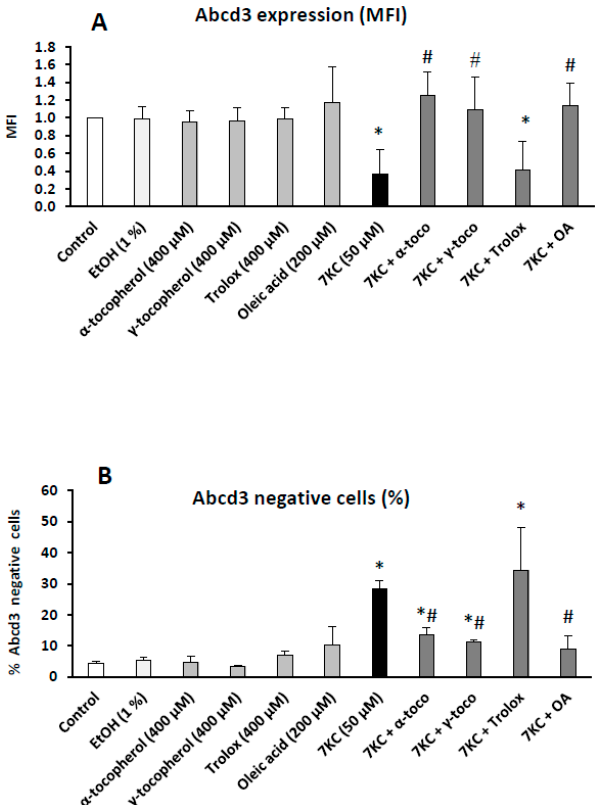
Figure 3. Protective effects of α -tocopherol, and γ -tocopherol, and oleic acid on 7-ketocholesterol-induced decreased expression of Abcd3, a marker of peroxisomal mass. Murine microglial BV-2 cells were cultured for 24 h in the presence of 7KC (50 µM) without and with α -, and γ -tocopherol (400 µM), Trolox (400 µM) and oleic acid (OA: 200 µM), and the expression of Abcd3 determined with the mean fluorescence intensity (MFI) was evaluated by flow cytometry ( A ); in addition, the percentage of Abcd3-negative cells was determined ( B ); No difference was observed between control and vehicle (EtOH 1%)-treated cells. The EtOH values correspond to the highest EtOH concentrations added to the culture medium: 1% with γ -tocopherol. Differences between vehicle and 7KC-treated cells (* means significant differences by Mann–Whitney test; p ≤ 0.05). Differences between 7KC-treated cells and (7KC + ( α -tocopherol, γ -tocopherol, or oleic acid))-treated cells (# means significant differences by Mann–Whitney test; p ≤ 0.05). Data are mean ± SD of at least three independent experiments.